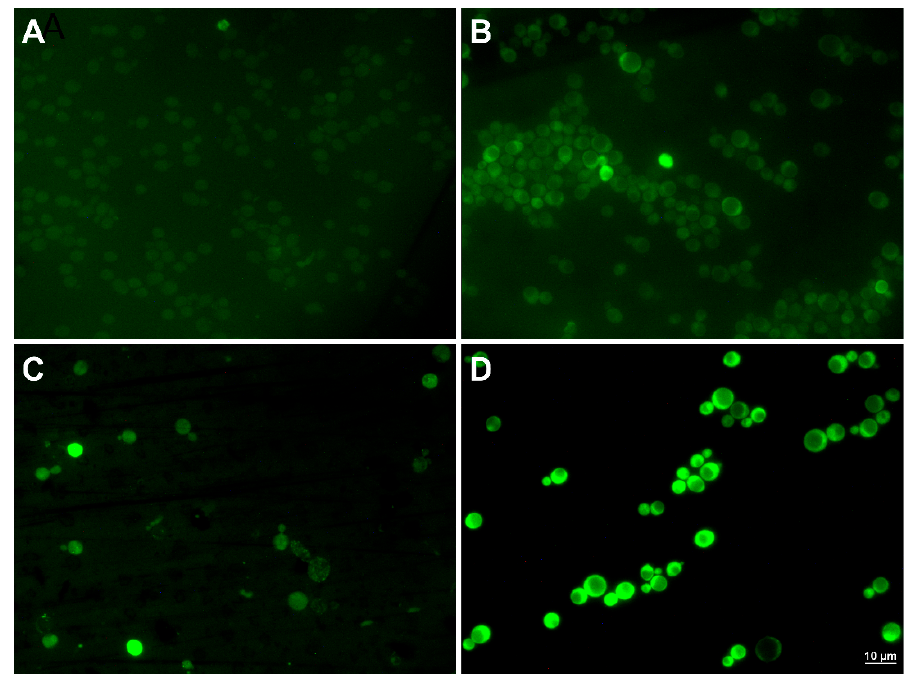
Figure 4. The micrographs of the cells of CRN and CRN / PPN1 strains of S. cerevisiae stained with 1,2,3-dihydrorhodamine. The strains were cultivated in control YPD medium with 14 mM KH 2 PO 4 , and in the same medium supplemented with 5 mM MnSO 4 to the logarithmic stage (control—12 h growth, both strains; 5 mM manganese—40 h growth, CRN; 16 h growth, CRN / PPN1). ( A ) CRN, control YPD; ( B ) CRN / PPN1, control YPD; ( C ) CRN, manganese excess; ( D ) CRN / PPN1, manganese excess.